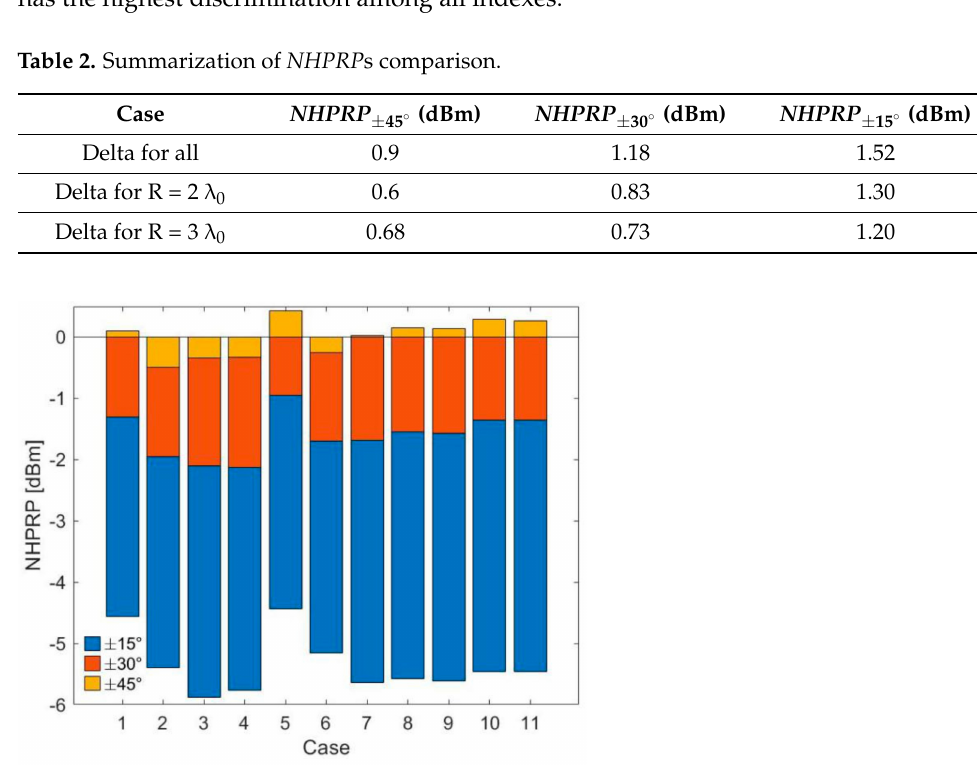
Figure 10. Comparison for different mounted locations and ground sizes ( NHPRP ± 15 ◦ , NHPRP ± 30 ◦ , and NHPRP ± 45 ◦